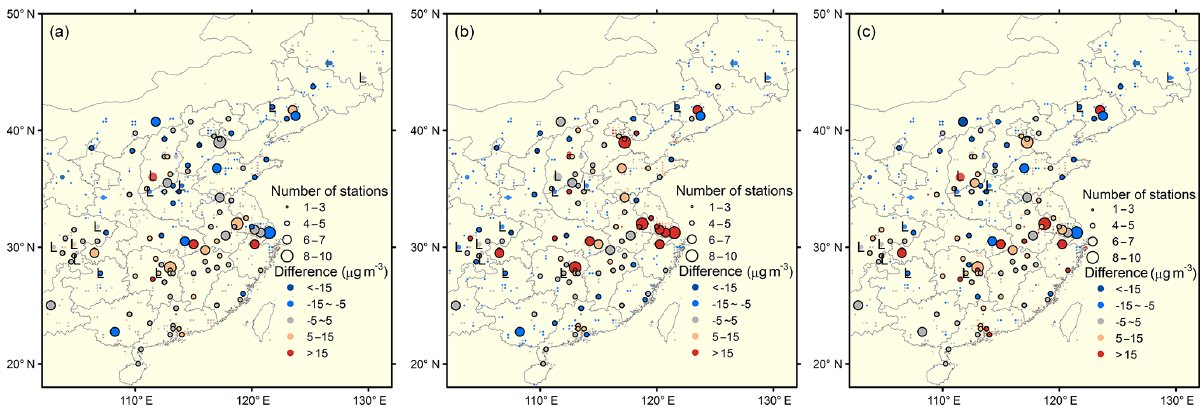
Figure 6. The normalized difference of annual mean surface NO 2 concentrations between model simulations and the corrected in situ measurements in 2015. The simulated NO 2 concentrations driven by (a) the DECSO inventory, 2015; (b) the MIX Asian inventory, 2010; and (c) the corrected DECSO inventory are subtracted from the corrected in situ measurements to derive the differences. The mean of the differences is further subtracted from the differences to derive the normalized differences. The magnitude of the size of symbols denotes the number of stations located in the same model grid cell. The color of the symbols denotes the difference of NO 2 concentrations. Grid cells with densely located stations are labeled with “L”. The outline of circles corresponding to “main sample” (see Table 2) is highlighted in